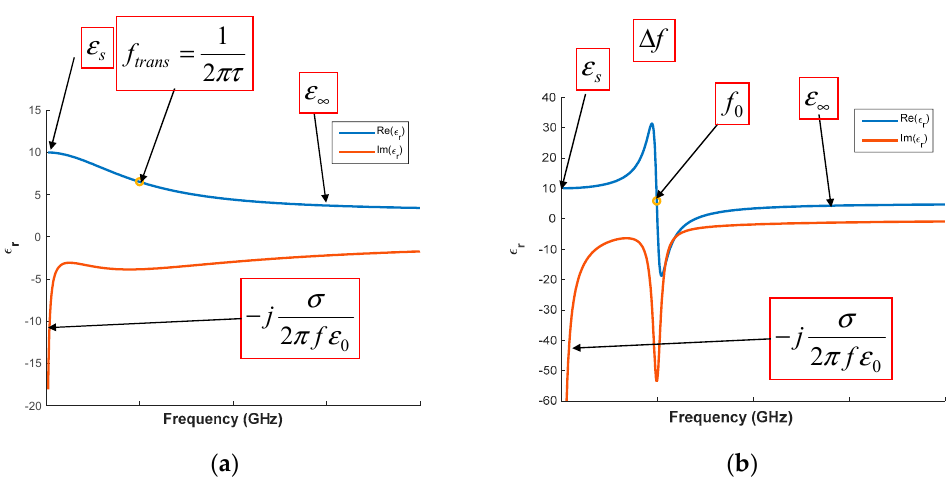
Figure 9. Real and imaginary parts as a function of the frequency of the electric permittivity in the case of the Debye ( a ) and Lorentz ( b ) models.